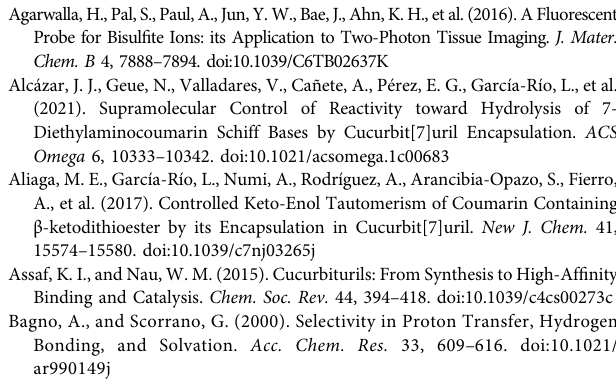
SCHEME 4 | Host-guest binding mechanism for a 1:1 stoichiometric